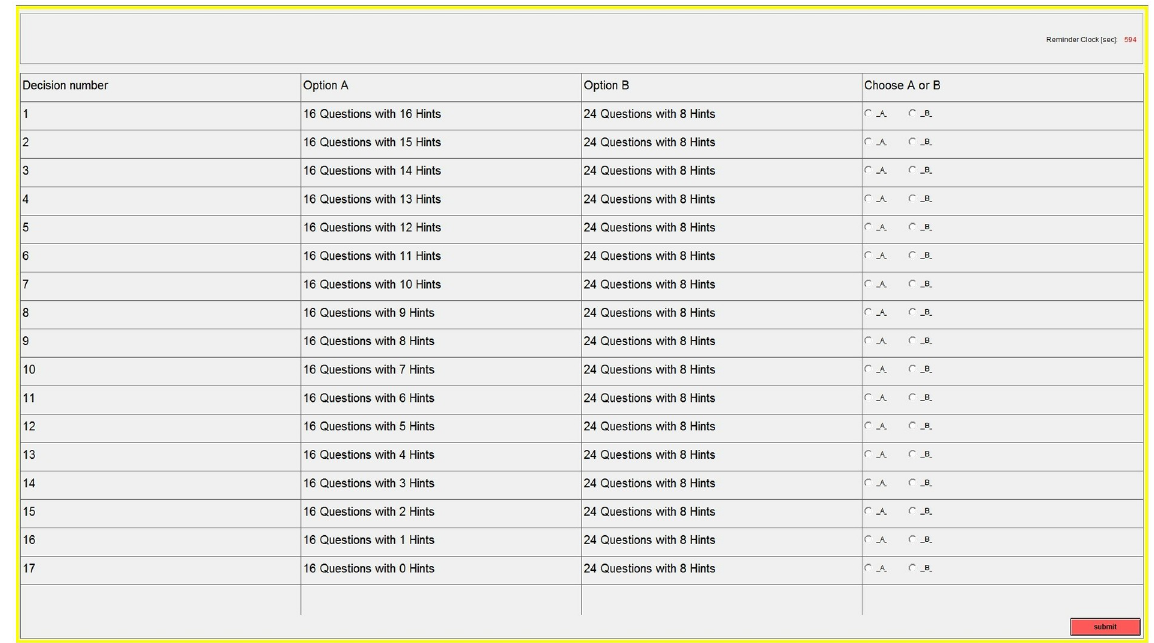
Fig 3. Binary choices in the multiple price